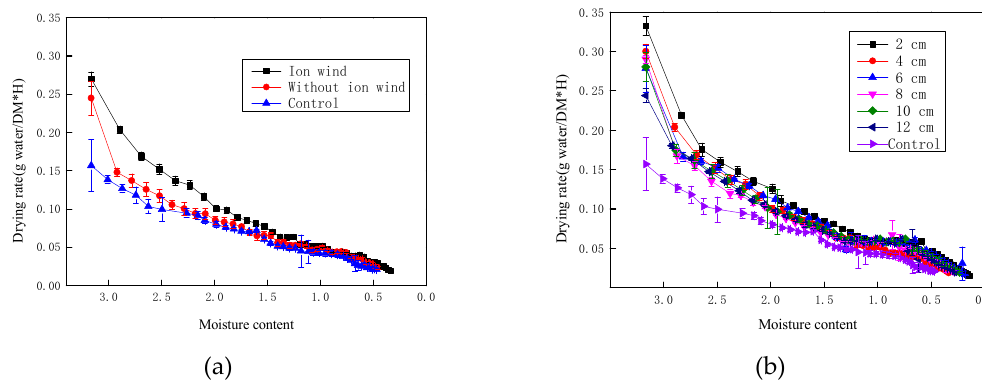
Figure 4. The drying rate of Chinese wolfberry fruits. ( a ) Ionic wind and without ionic wind; ( b ) different needle spacing.